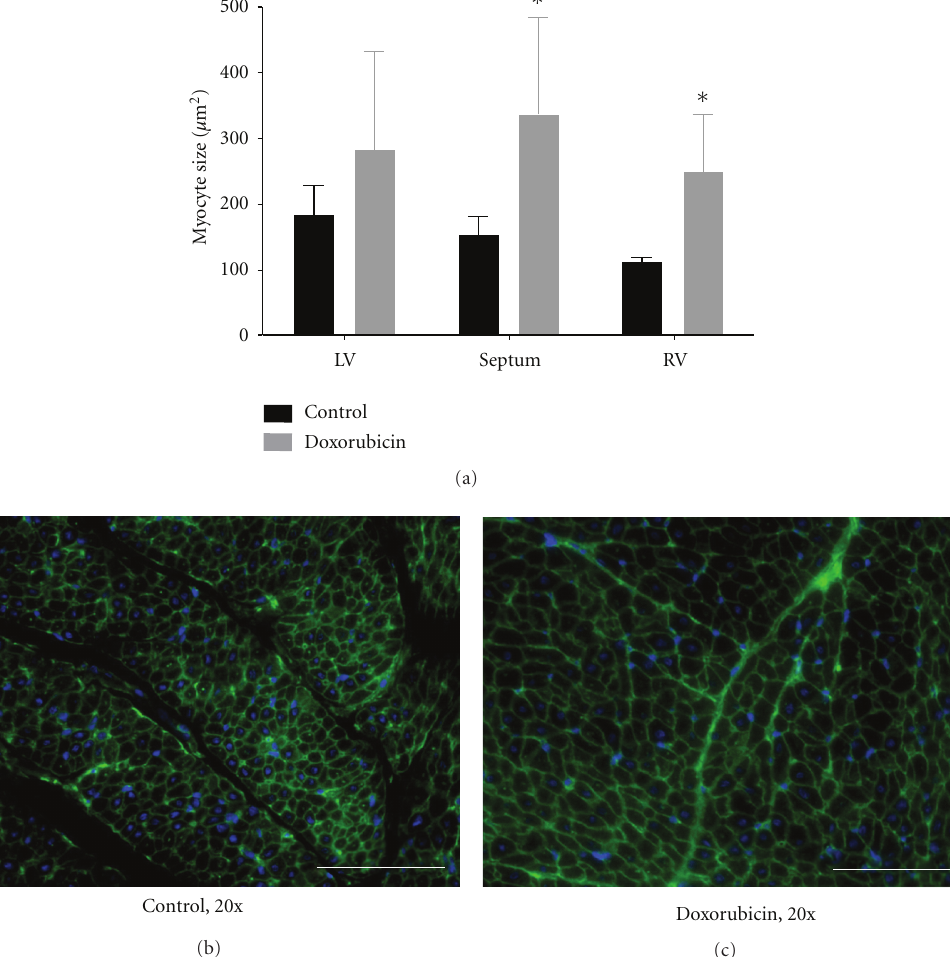
Figure 5: (a) Myocyte area as determined by wheat germ agglutinin and DAPI costaining in control and doxorubicin-treated hearts. (b) and (c) Representative wheat germ agglutinin and DAPI costaining in control and doxorubicin-treated hearts delineating myocyte cell membranes (green) and nuclei (blue). In control animals, myocytes are of a uniform size and shape, and interstitial space is clearly visible as dark, variegated bands through the myocardium. In doxorubicin-treated animals, myocytes are hypertrophic and nonuniform in shape. 20x, white bar = 100 μ m, ∗ P < 0 . 05 versus control. LV, left ventricle; RV, right ventricle; n =